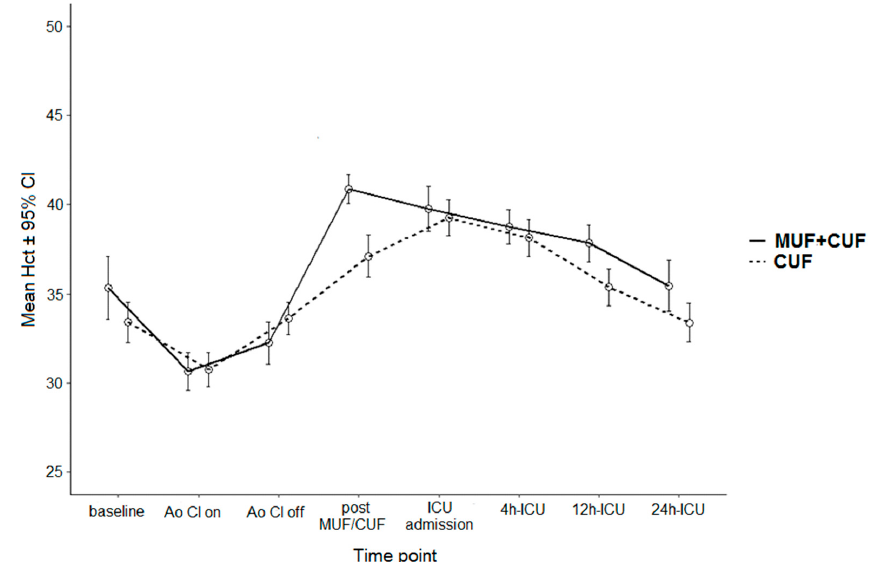
Figure 1. Hematocrit data for overall cohort—Ao Cl on—cross clamp on; Ao Cl off—cross clamp off; MUF—modified ultrafiltration; CUF—conventional ultrafiltration, ICU—intensive care unit.